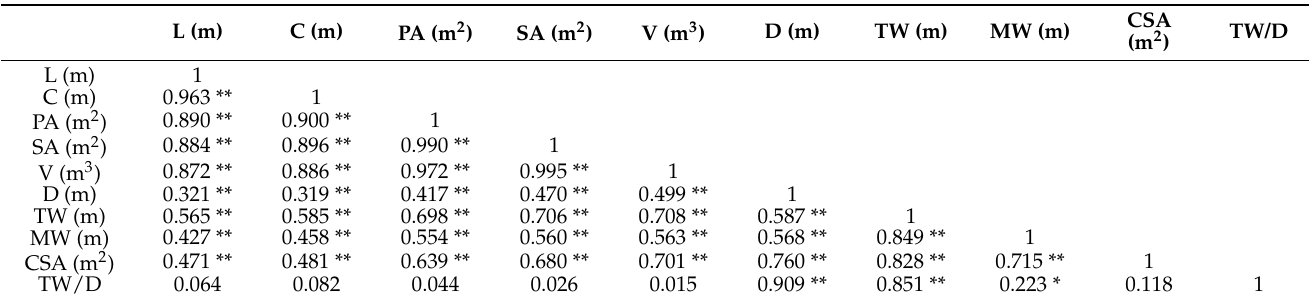
Table 3. Pearson’s correlation coefficients between different gully morphological parameters (n =